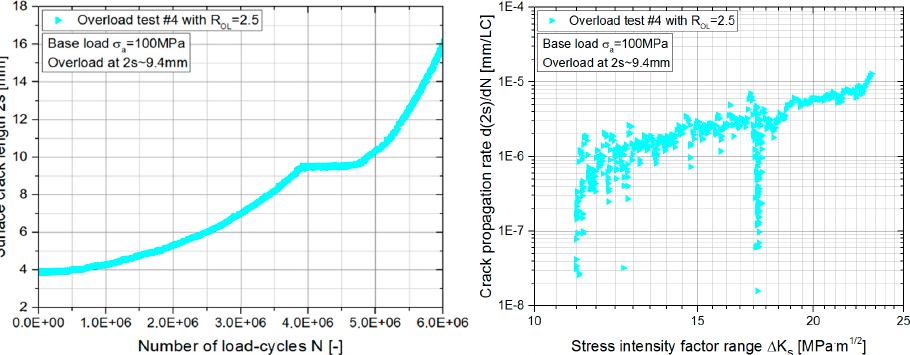
Figure 9. Results of Overload test #3 with R OL = 2.5 ( a ) surface crack length versus load-cycles; ( b ) crack propagation rate vs. stress intensity factor.